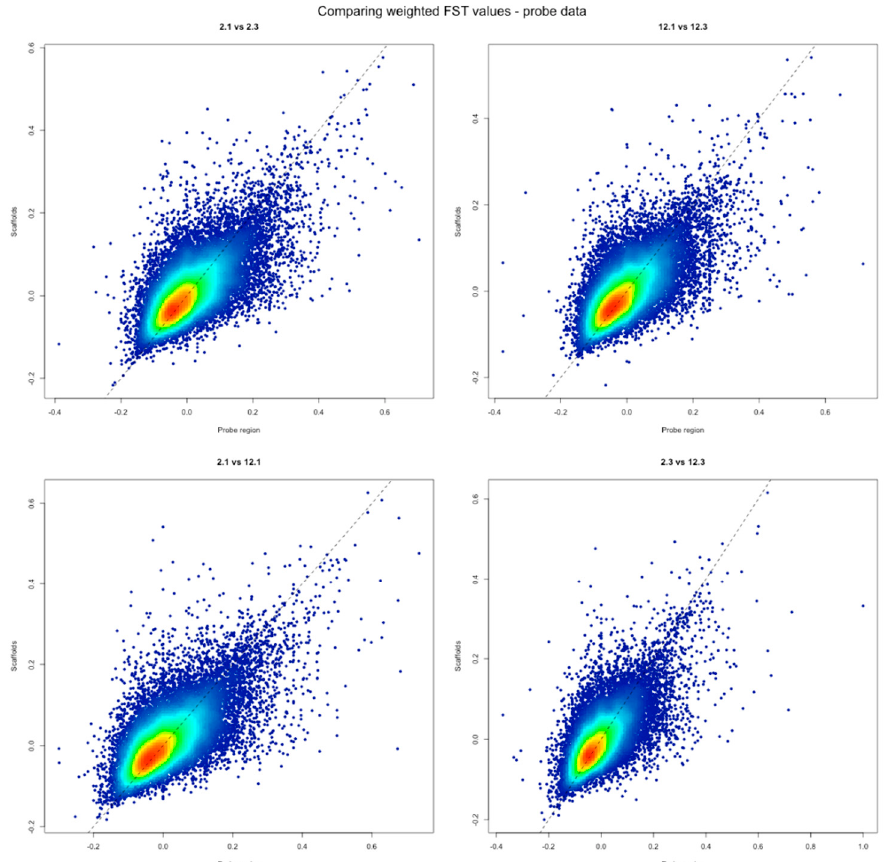
Figure 4. Comparing Fst values between populations in the probe data. Population 2.1 is an old costal population and 2.3 a young, recently planted costal population. 12.1 is an old population from the mountain region in Västerbotten county and 12.3 is a newly planted population in the mountain region. Red indicates the highest number of data points and dark blue the lowest.